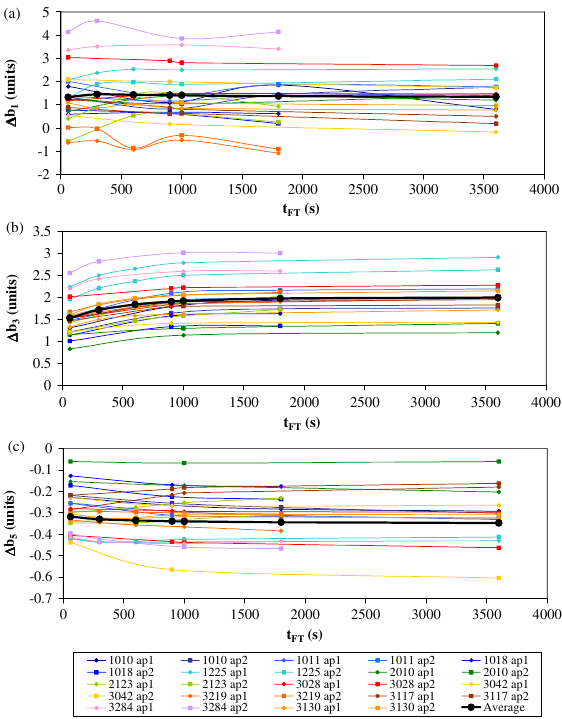
FIG. 14. (Color) The variation of the decay amplitude with flattop duration for (a) b